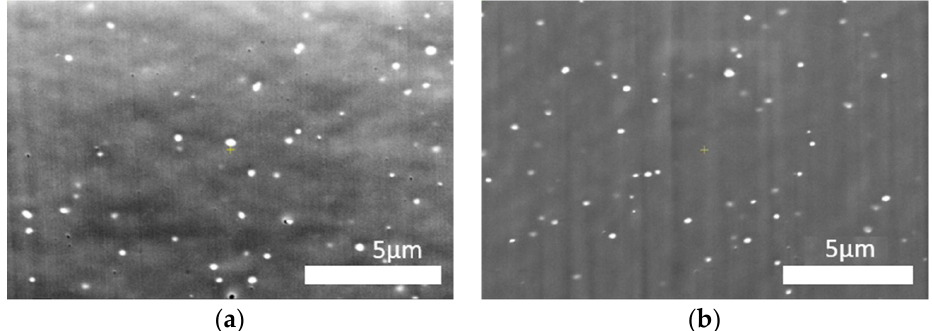
Figure 4. Distribution of nanoparticles in PAN fibers: ( a ) cross-section; ( b ) longitudinal section.